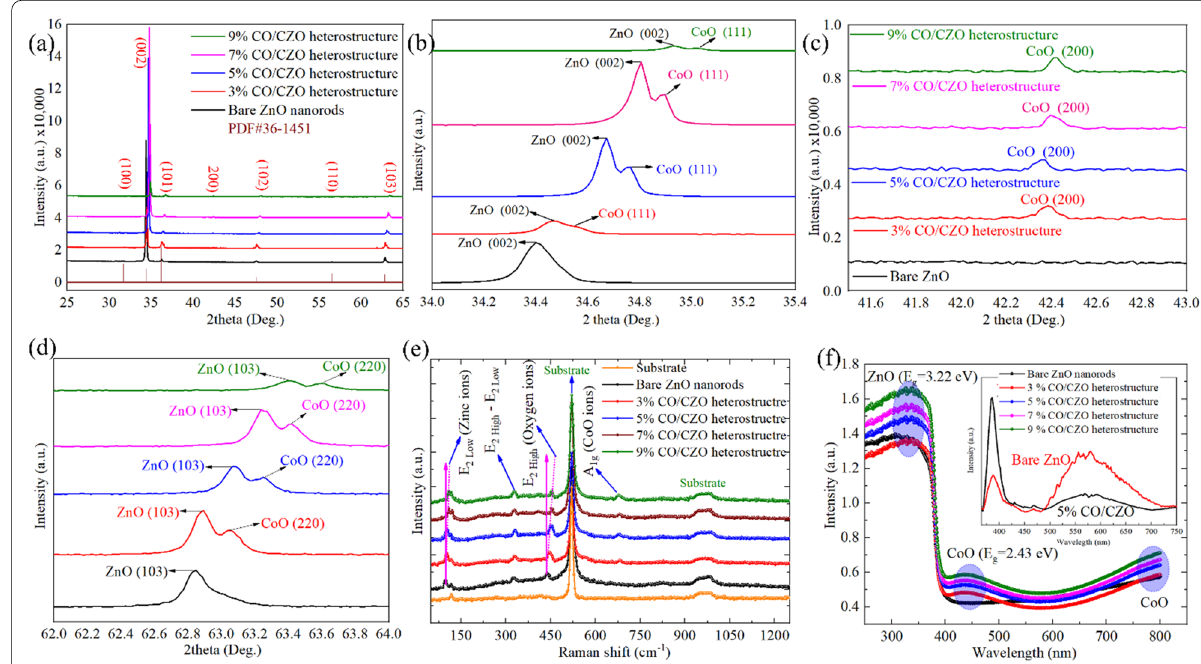
Fig. 3 XRD pattern of a ZnO nanorods and CO/CZO heterostructure nanorods. Magnified view of b plane (002), c plane (200), and d plane (103). e Raman and f UV–visible absorption and spectra of bare ZnO and 3%, 5%, 7%, and 7% CO/CZO heterostructure, where the inset shows the spectra of bare and 5% CO/CZO